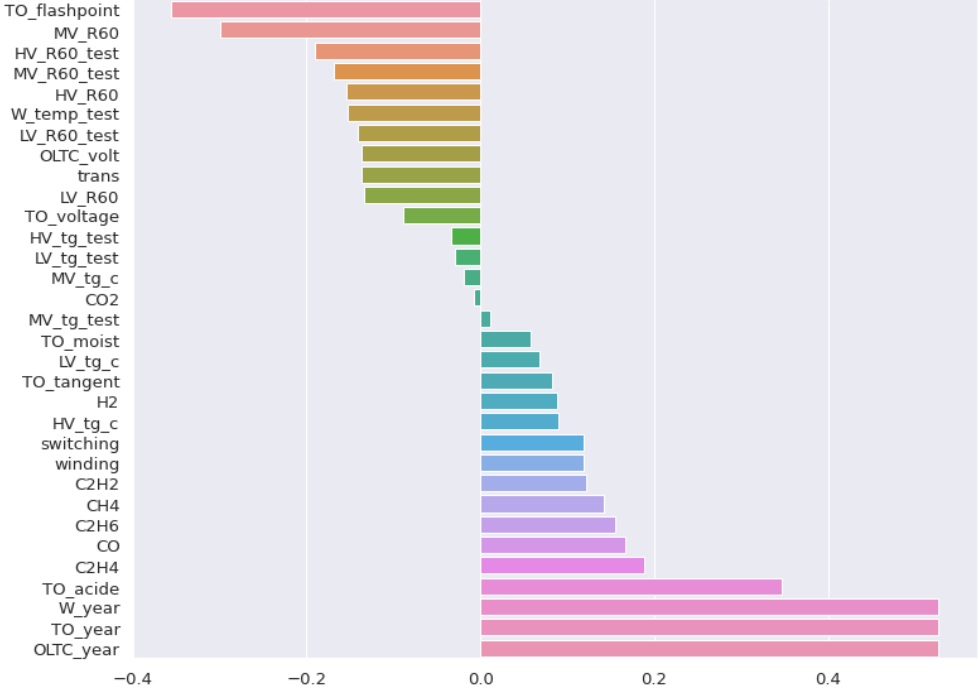
Figure 9. Spearman correlation coefficients in relation to the power transformer state.